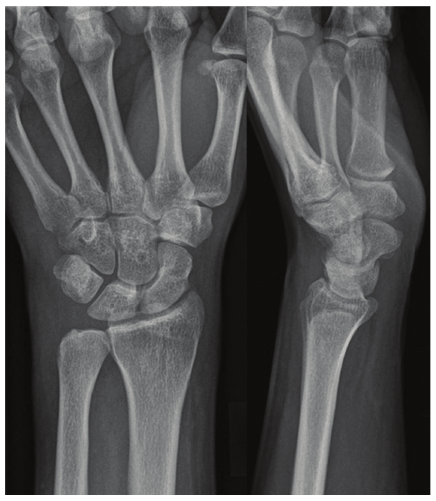
Figure 3: An open surgical treatment was performed, with resection of the styloid process of ulna, synovectomy, and inspection of the review fibrocartilage triangular, which was intact. The material was sent to pathology, reported as osteoid osteoma with involvement of the synovial tissue with chronic fibrovascular